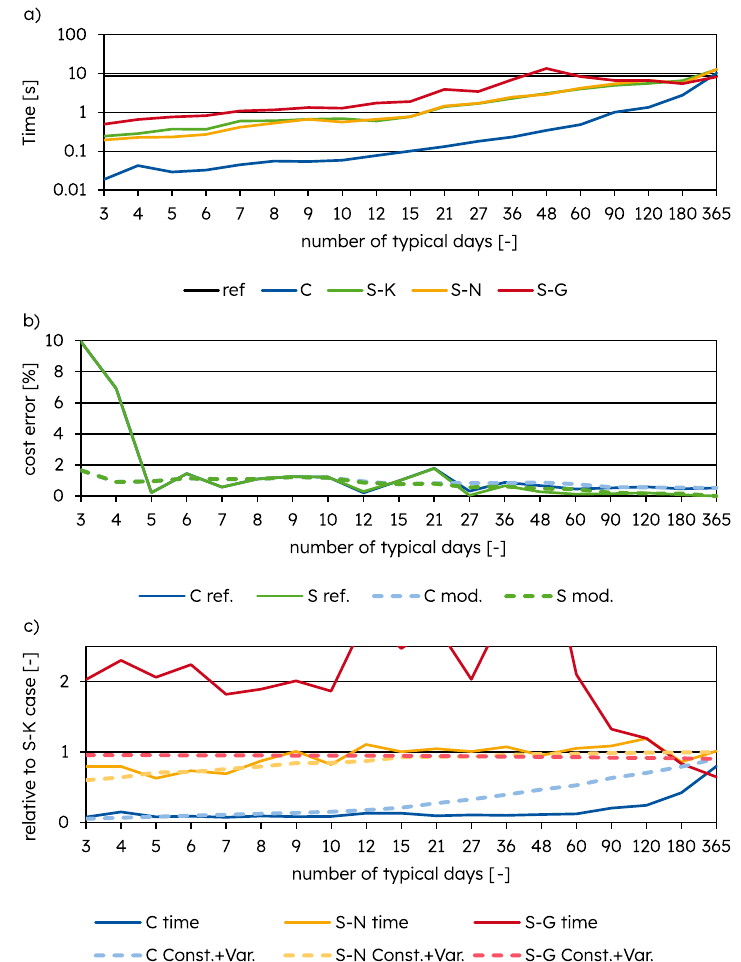
Fig. 4 Calculation time ( a ) and total costs error ( b ) for the different storage models and relative share of number of constraints and variables as well as time for C, S-G- and S-N- to S-K-model ( c ) for the air heat pump